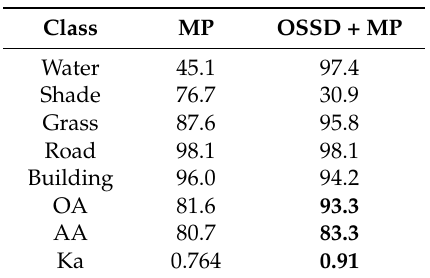
Table 4. Aerial image classification accuracies for the test using only the MP feature and OSSD integrated with MP based on